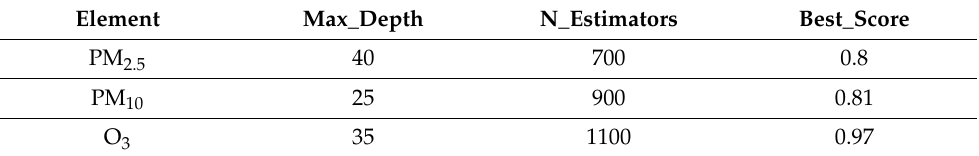
Table 3. RF Optimal parameters.